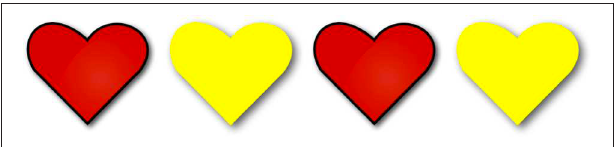
FIGURE 3 | Example of an image presented in the GAP condition. The first and third hearts are red, while the second and fourth hearts are yellow. The corresponding homogeneity target sentence was either Les coeurs sont rouges “The hearts are red” or Les coeurs ne sont pas rouges “The hearts are not